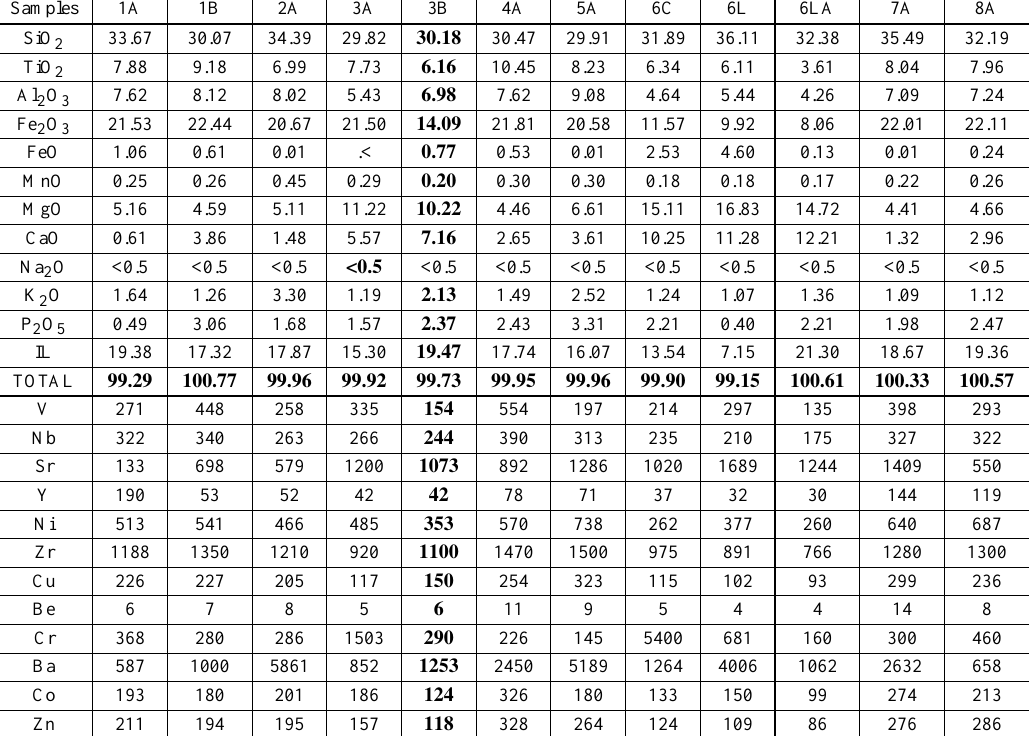
Whole-rock chemistry of Mata da Corda volcanic rocks from road cuts in the Presidente Olegário region. Major element oxides are expressed in weight %, and minor elements in ppm. Dept. Geoquímica, UnB (Geraldo Boaventura, analyst) (S.M.C.H. Theodoro, unpublished